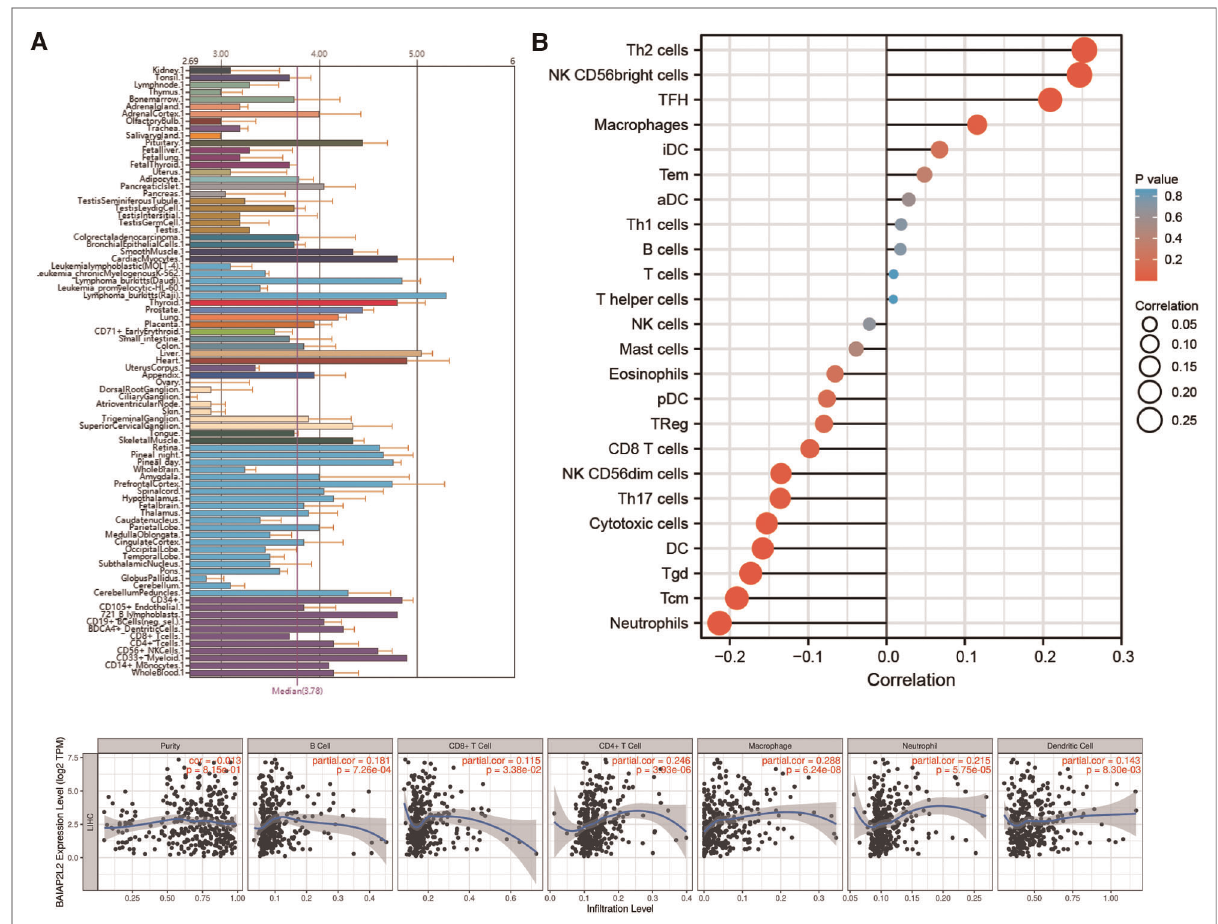
FIGURE 8 Correlation of BAIAP2L2 expression with the immune in fi ltration level. ( A ) Immune cell in fi ltration analysis of BAIAP2L2 in BioGPS. ( B ) The forest plot shows the correlation between BAIAP2L2 expression level and 24 immune cells. ( C ) BAIAP2L2 is signi fi cantly associated with tumor purity and is positively correlated with the in fi ltration of different immune cells using the TIMER